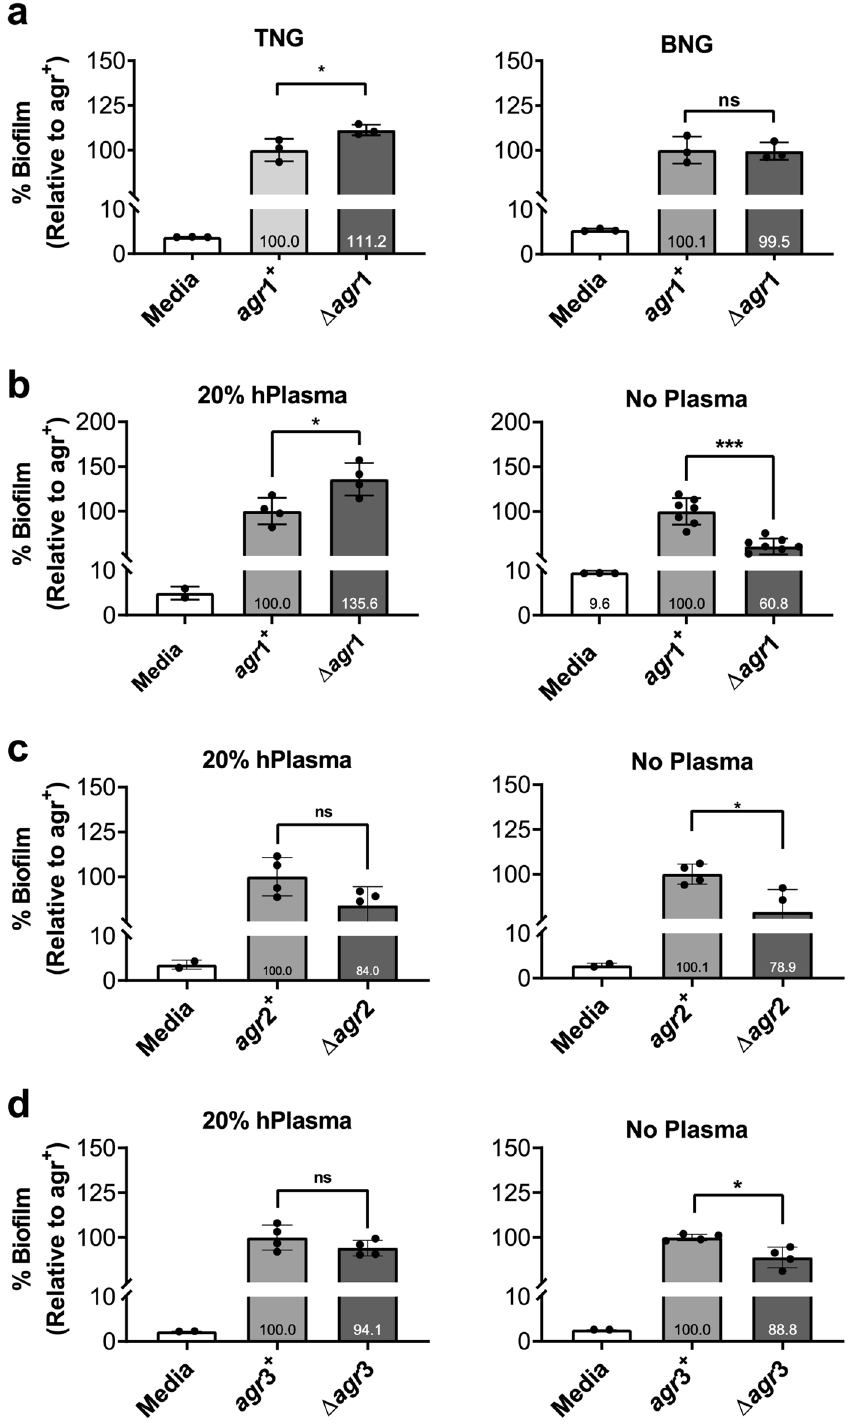
Figure 1. Strain and condition dependence of Δagr biofilm enhancement in vitro. ( a ) Comparison of agr 1 biofilm grown with 20% human plasma in TSB + 3% NaCl + 0.05% Dextrose (TNG) versus BHI + 3% NaCl + 0.05% Dextrose (BNG). ( b ) Comparison of agr 1 biofilm grown in TNG with 20% human plasma (left) or without (right). ( c ) Comparison of agr 2 grown in TNG with 20% human plasma (left) or without (right). ( d ) Comparison of agr 3 grown in TNG with 20% human plasma (left) or without (right). Percent biofilm growth is relative to the agr + strain. The agr 1 strain is AH1263 and its isogenic deletion mutant is AH1292, and the agr 2 and agr 3 are the S. aureus strains 502A and MW2, respectively with their isogenic deletion mutants. Data represent ≥ 3 biological replicates and are expressed as the mean ± SD (* p < 0.05, *** p < 0.001, **** p < 0.0001, ns = not